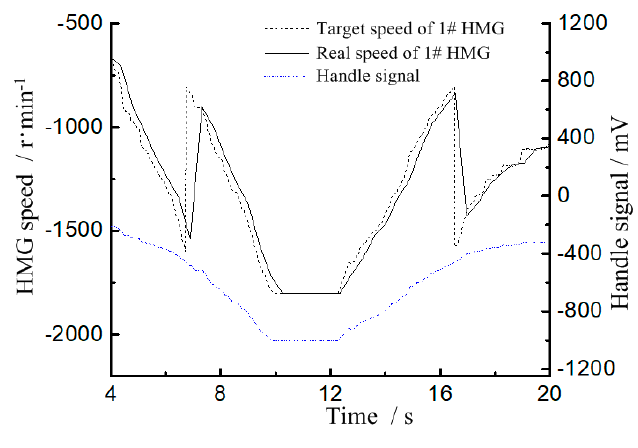
Figure 14. Relationship between the rodless chamber pressure and handle signal.